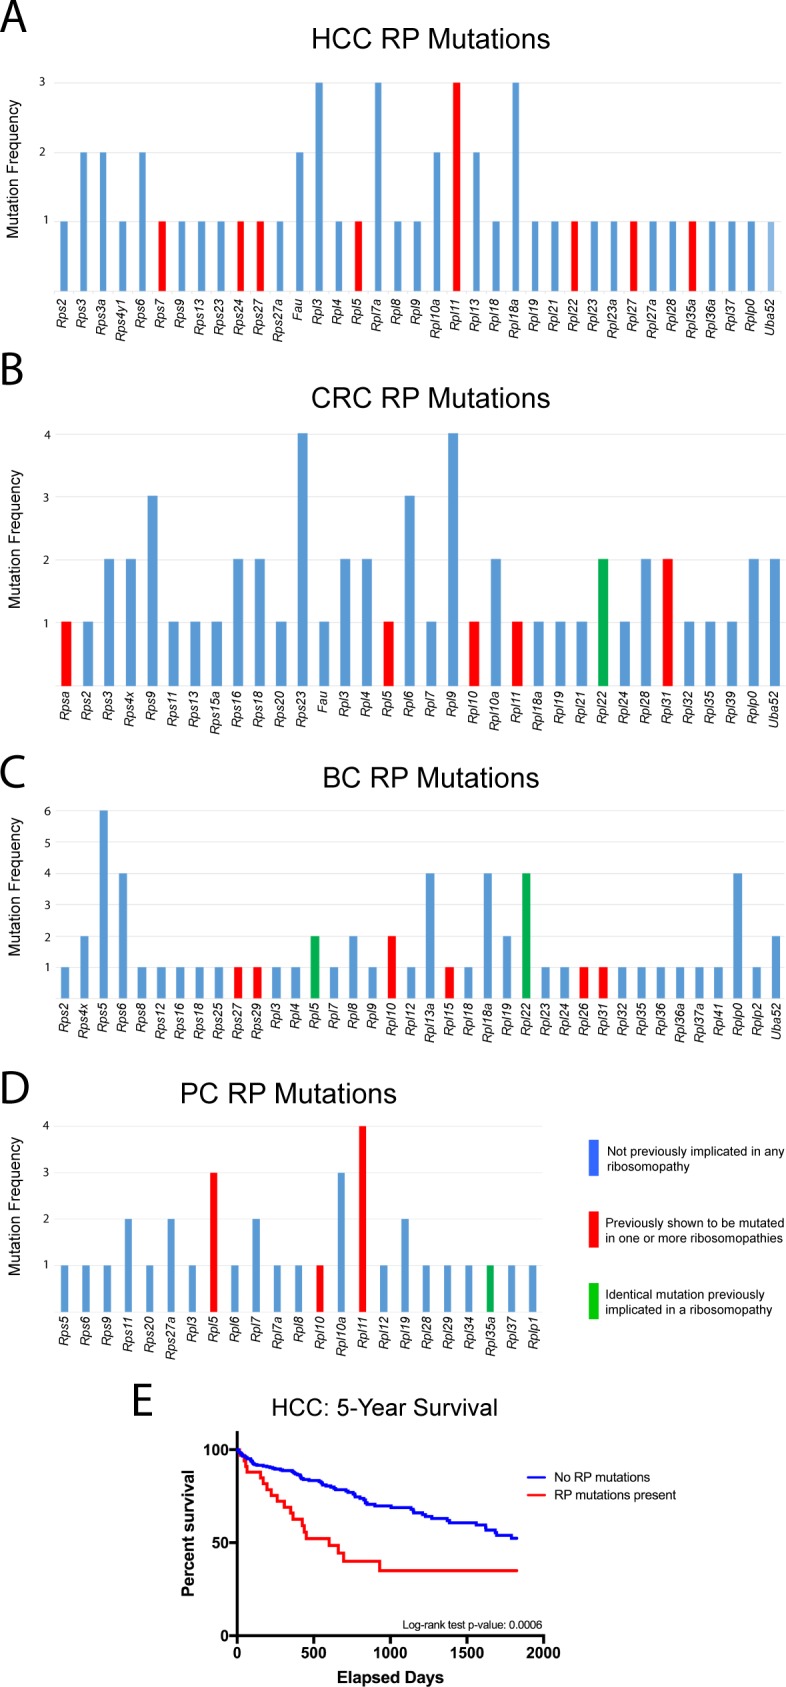
RP transcript mutations identified in human cancers.The results of RP mutational analysis were obtained from the sequence data shown in Fig 3. The total number of mutations involving any given RP are plotted along the ordinate. All mutations identified are listed individually in Tables F-G in S1 File. (A). HCCs. (B). Colo-rectal cancers (CRCs). (C). Breast cancers (BC). (D). Prostate cancers (PC). Identical mutations previously implicated in a ribosomopathy include: K89Nf2*3 and K15Rfs*5 in Rpl22 in CRC; N57Efs*12 and A97G in Rpl5, and K15Rfs*5 in Rpl22 in BC; and V33I in Rpl35A in PC. Previously described RP mutations were identified in refs. 1,2,5,6,9,43–45 and http://www.dbagenes.unito.it/home.php. (E). Survival of HCC patients with and without RP transcript coding mutations.